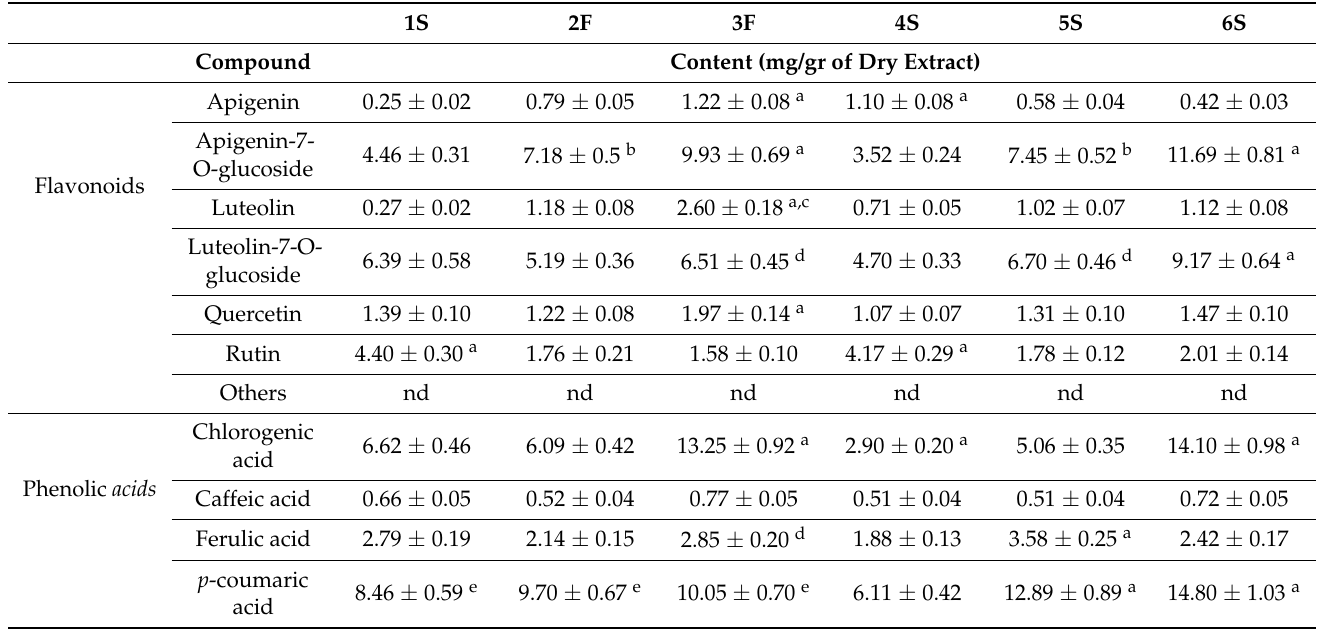
Figure 3. Total content of flavonoids, phenolic acids and other phenols identified by HPLC analysis. Results are expressed as mg of compound per gram of dry extract except for “other phenols” that are expressed as chlorogenic acid equivalents (CAE). Data are the means ± SEM of 3 independent extractions. * p < 0.05 vs. 4S and 5S; ** p < 0.01 vs. 1S, 2F, 4S and 5S; *** p < 0.001 vs. 1S, 2F, 4S and 5S; # p < 0.05 vs. 3F. Table 2. Phenolic profile of chamomile samples through HPLC